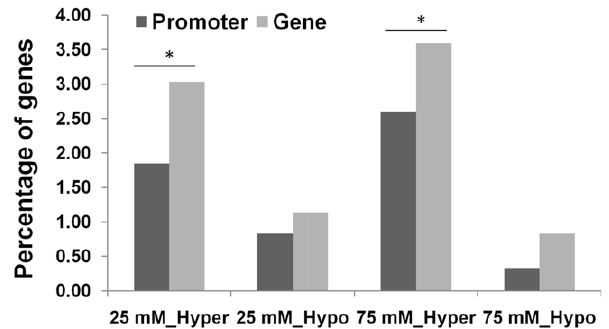
Figure 2. Percentage of differentially methylated genes. The figure shows the percentage of genes that are hyper- or hypomethy- lated at the promoter or gene body regions in the progeny of stressed (25 or 75 mM) plants as compared to the progeny of non-stressed control plants. ‘‘25_Hypo’’ and ‘‘75_Hypo’’ – stand for hypomethylated regions in the progeny of plants exposed to 25 and 75 mM NaCl, respectively. ‘‘25_Hyper’’ and ‘‘75_Hyper’’ – represent hypermethylated regions in the progeny of plants exposed to 25 and 75 mM NaCl, respectively. The asterisks denote a significant difference between the percentage of hypermethylated and hypomethylated regions (p , 0.05; single-factor Anova).